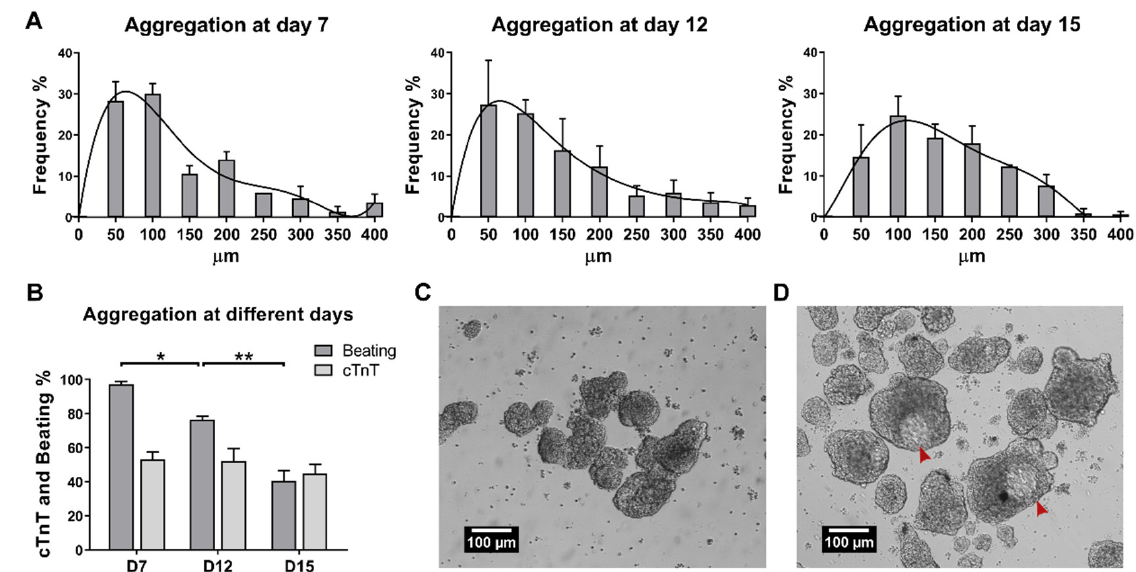
Figure 1. Manual induction of aggregation is reliable and cost-effective when performed at day 7. ( A ) Aggregate size distribution for mechanical aggregation performed at day 7, day 12, or day 15 of cardiac differentiation. Aggregation at day 7 and day 12 promoted a higher frequency of aggregates with a size of 50 and 100 µ m. At day 15, aggregation yielded a higher variance population. The lines correspond to centered sixth order polynomials that model size distribution. Error bars, SEM, n = 3. ( B ) Percentage of beating aggregates and percentage of cells expressing cTnT (determined by flow cytometry) at day 18 of cardiac differentiation. Aggregation at day 7 resulted in an average of 97% aggregates with a beating phenotype and 53% cTnT-positive cells. Error bars, SEM, n = 3. * p -value < 0.05, ** p -value < 0.01, (ANOVA with Tukey’s test). ( C , D ) Aggregates at day 10 ( C ) and day 15 ( D ) of differentiation after aggregate induction at day 7. Some aggregates appeared to develop structures with different depths (red arrows). Scale bar: 100 µm.